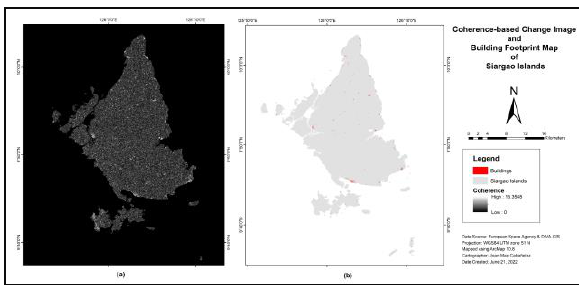
Figure 7 . Coherence-based change image and building footprint of Siargao Islands